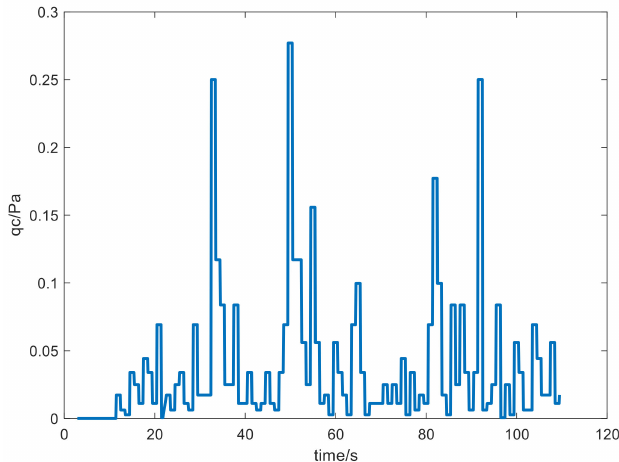
Figure 26. Calculated dynamic pressure results.